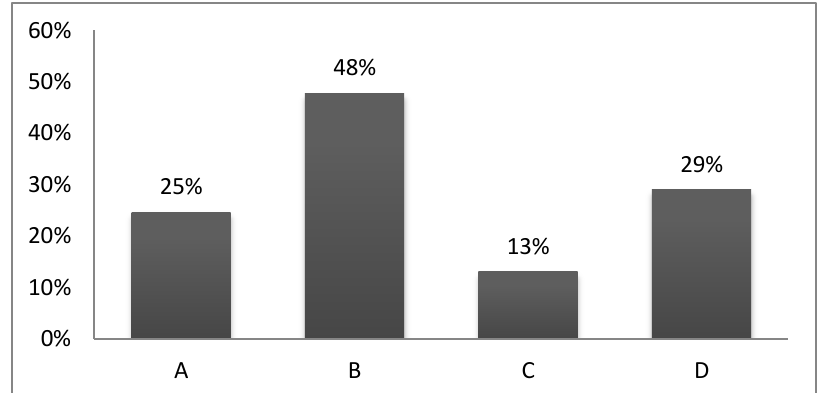
Figure 4.1: the Islamic students’ goal in learning